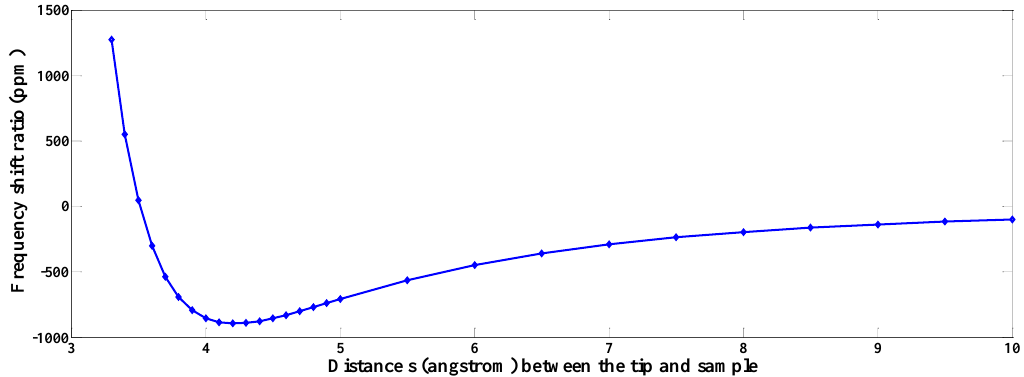
Figure 11. Frequency shift ratio versus the tip-sample distance, including the short-range repulsive regime. However, the relationship between the frequency shift and the force gradient is not available from QTF measurement. This hindered us finding the tip-sample force, but it can be obtained by solving the equations of motion established from proper physical modeling. From the equation ( ) s